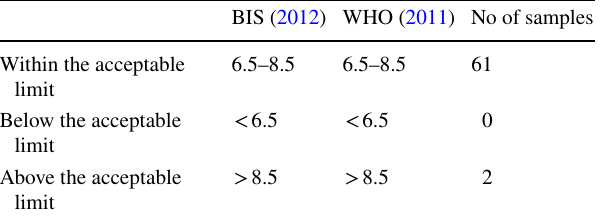
Table 3 pH—comparison with BIS (10,500:2012) and WHO (2011) limits